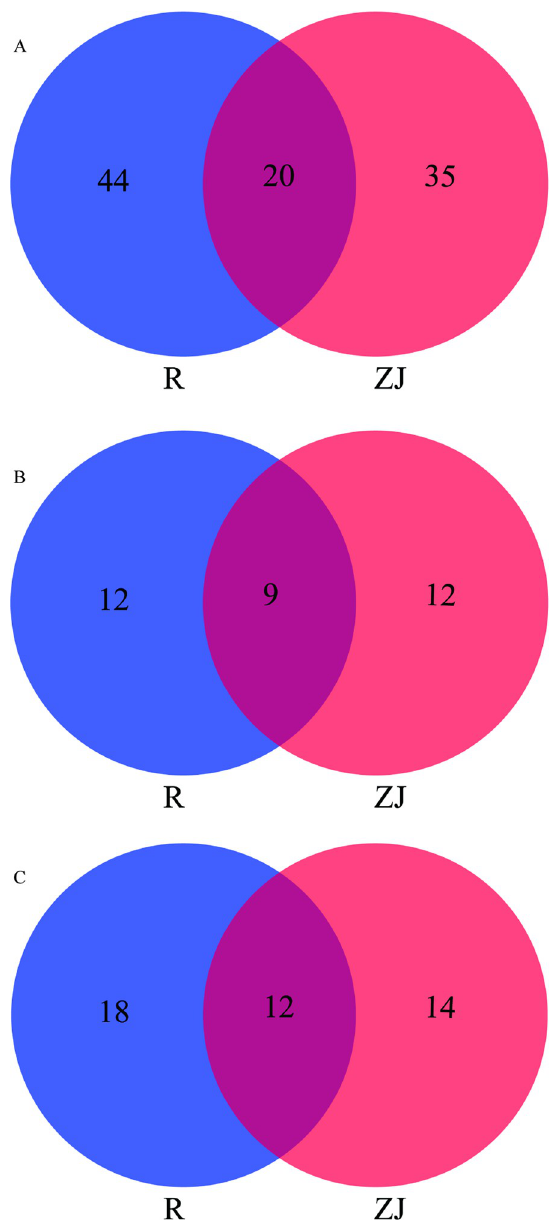
Fig 7. Co-upregulated gene number of P450s (A), GSTs (B) and CarEs (C) genes, based on RNA-Seq, after Serratia oryzae enriched. The intersections represent the number of up-regulated genes after bacterial enrichment in both field (ZJ mosquitoes) and laboratory (R mosquitoes)